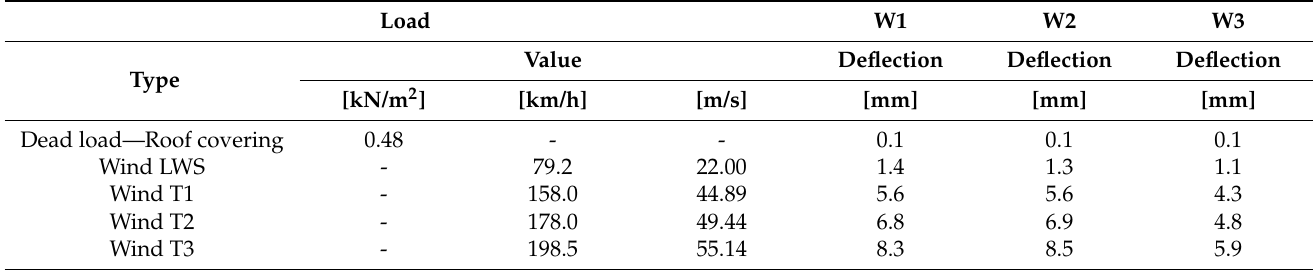
Table 4. Tabular list of displacement values for winds W1, W2, W3. Load W1 W2